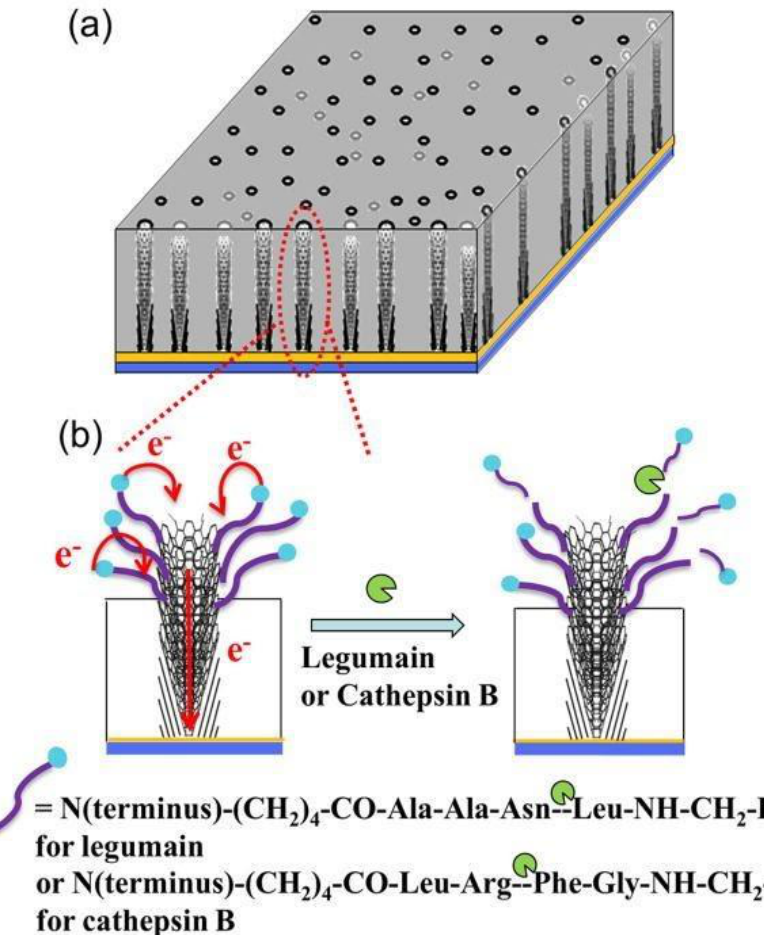
Figure 6. Biosensors formed using carbon nanofibers showing distinct properties. (a); represent CNFs vertically aligned in SiO 2 matrix. (b); shows electrons transfer and loss of electrochemical signal from ferrocene attached at the distal end of peptide. This loss of signal is due to the cleavage of peptide at a specific site [70]. Copyright 2013, American Chemical